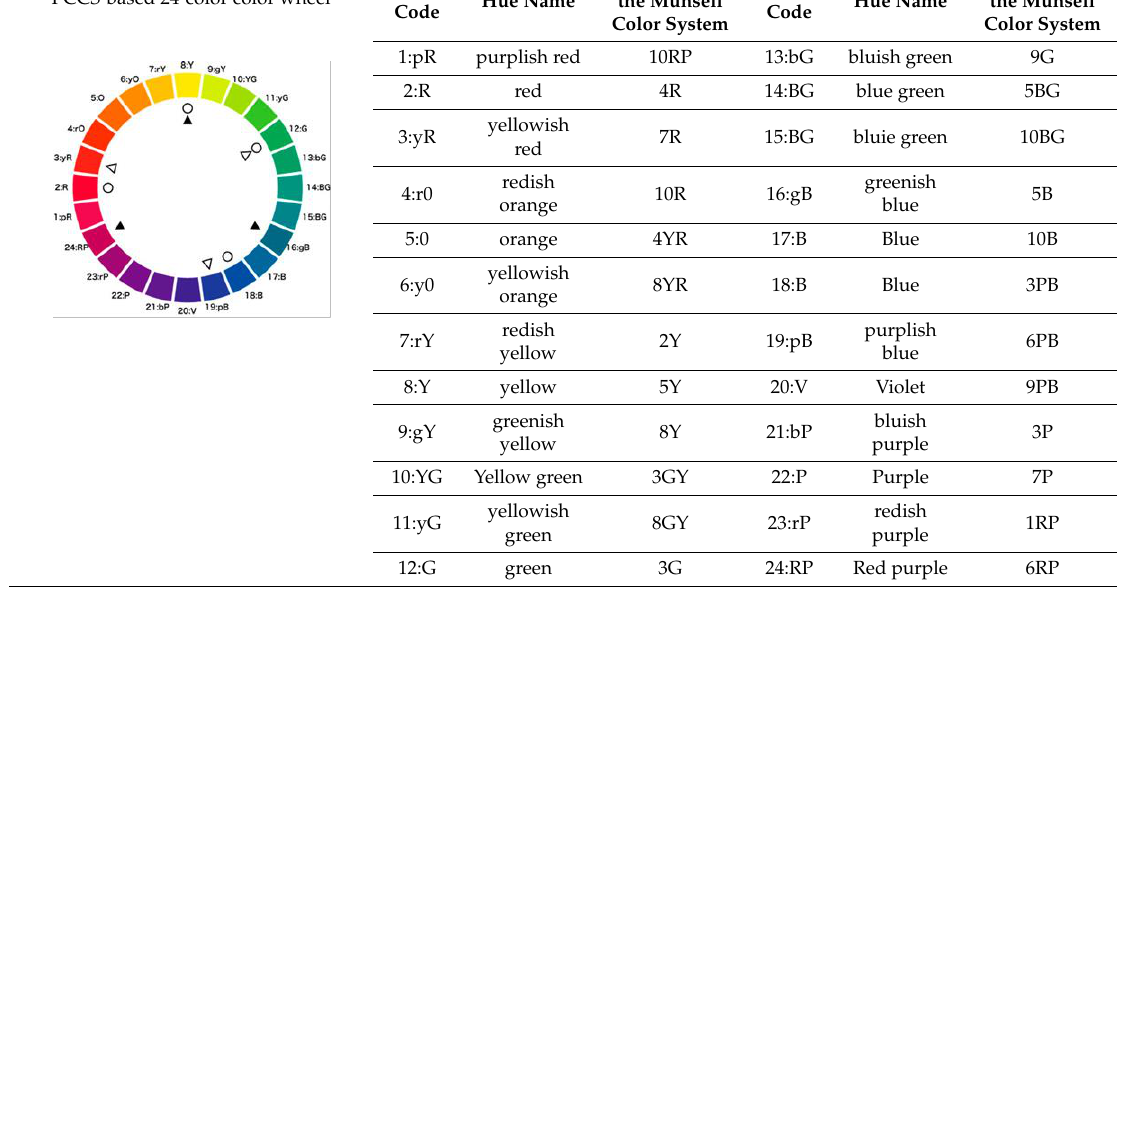
Table 3. The 36 experimental color scheme designs.